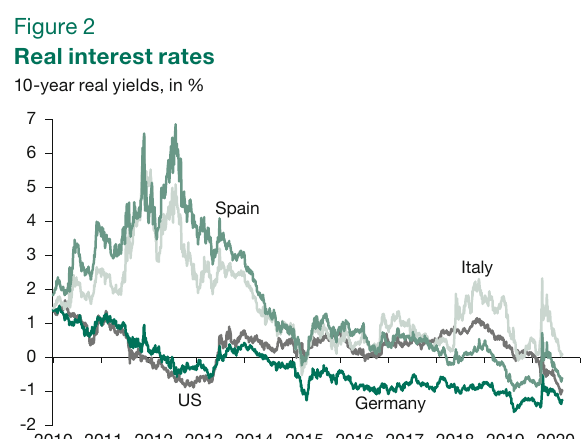
Figure 2 Real interest rates 10-year real yields, in %